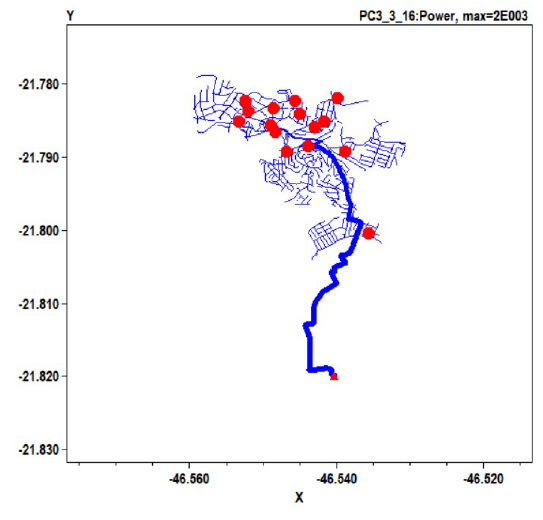
Figure 7. Location of 25% of the 75 kVA